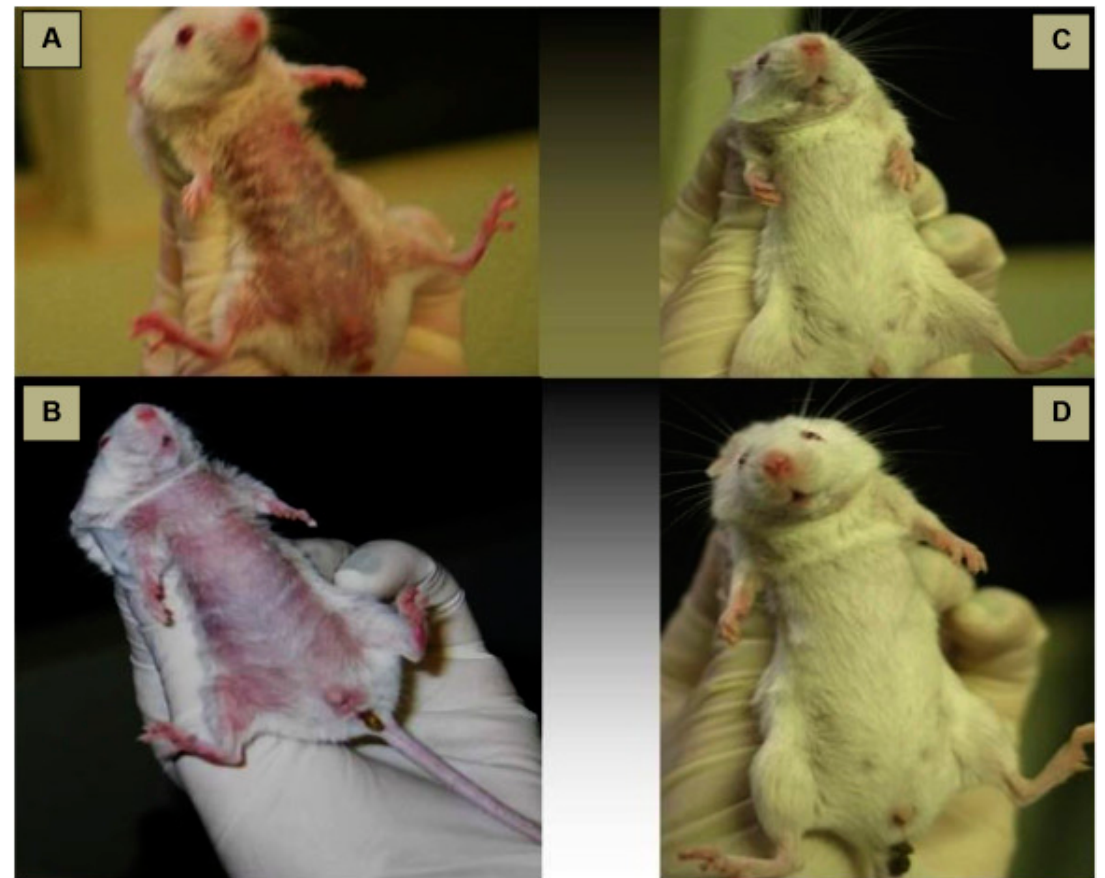
Figure 6. P. brasiliensis -infected BALB / c mice in sections ( A ) and ( B ) presented alopecia after the treatment of free ITZ whereas P. brasiliensis -infected BALB / c mice in sections ( C ) and ( D ) after the treatment of Nano-D-ITZ presented normal pelage [107].